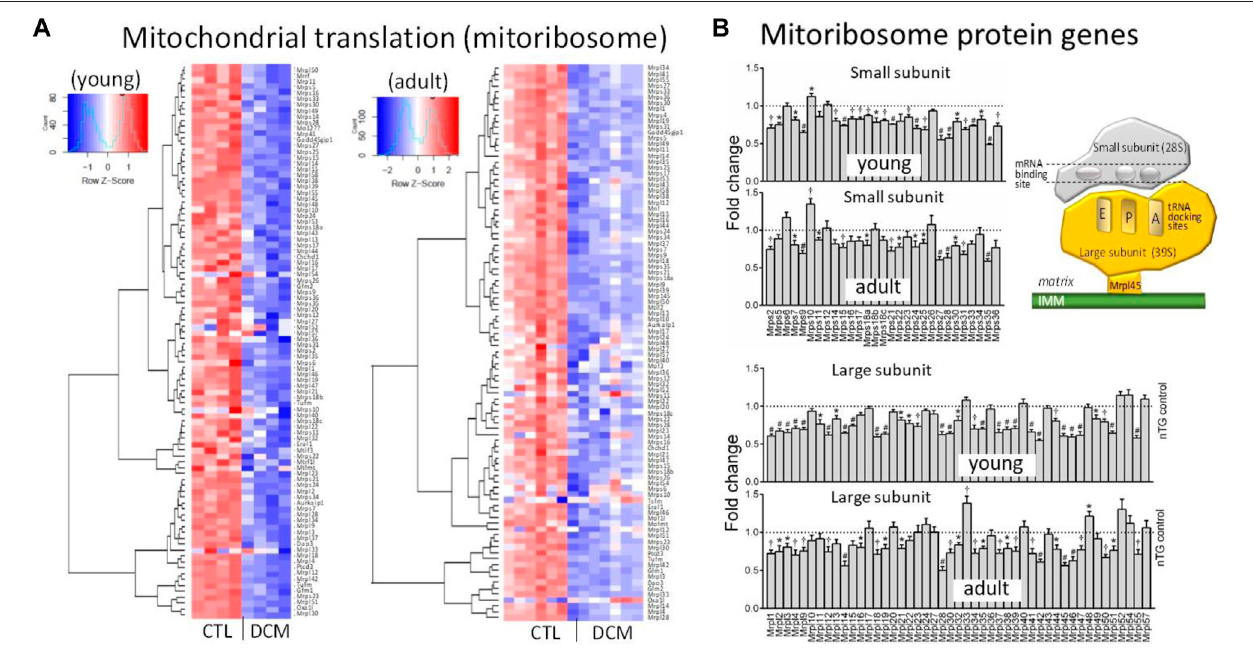
FIGURE5| DysregulatedexpressionofgenesforsubunitsofmitoribosomeinDCMhearts. (A) Heatmapforexpressionofgenescodingsubunitsofmitoribosome. (B) Bar graphs presenting changes in individual genes of components of small subunits (Mrps) and large subunits (Mrpl) of mitoribosome. * p < 0.05, † p < 0.01, # p < 0.001 vs. respective Control. Inserted cartoon depicting the assembly of small and large subunits of mitoribosome and the contacting site to inner mitochondrial membrane (IMM) via Mrpl45.